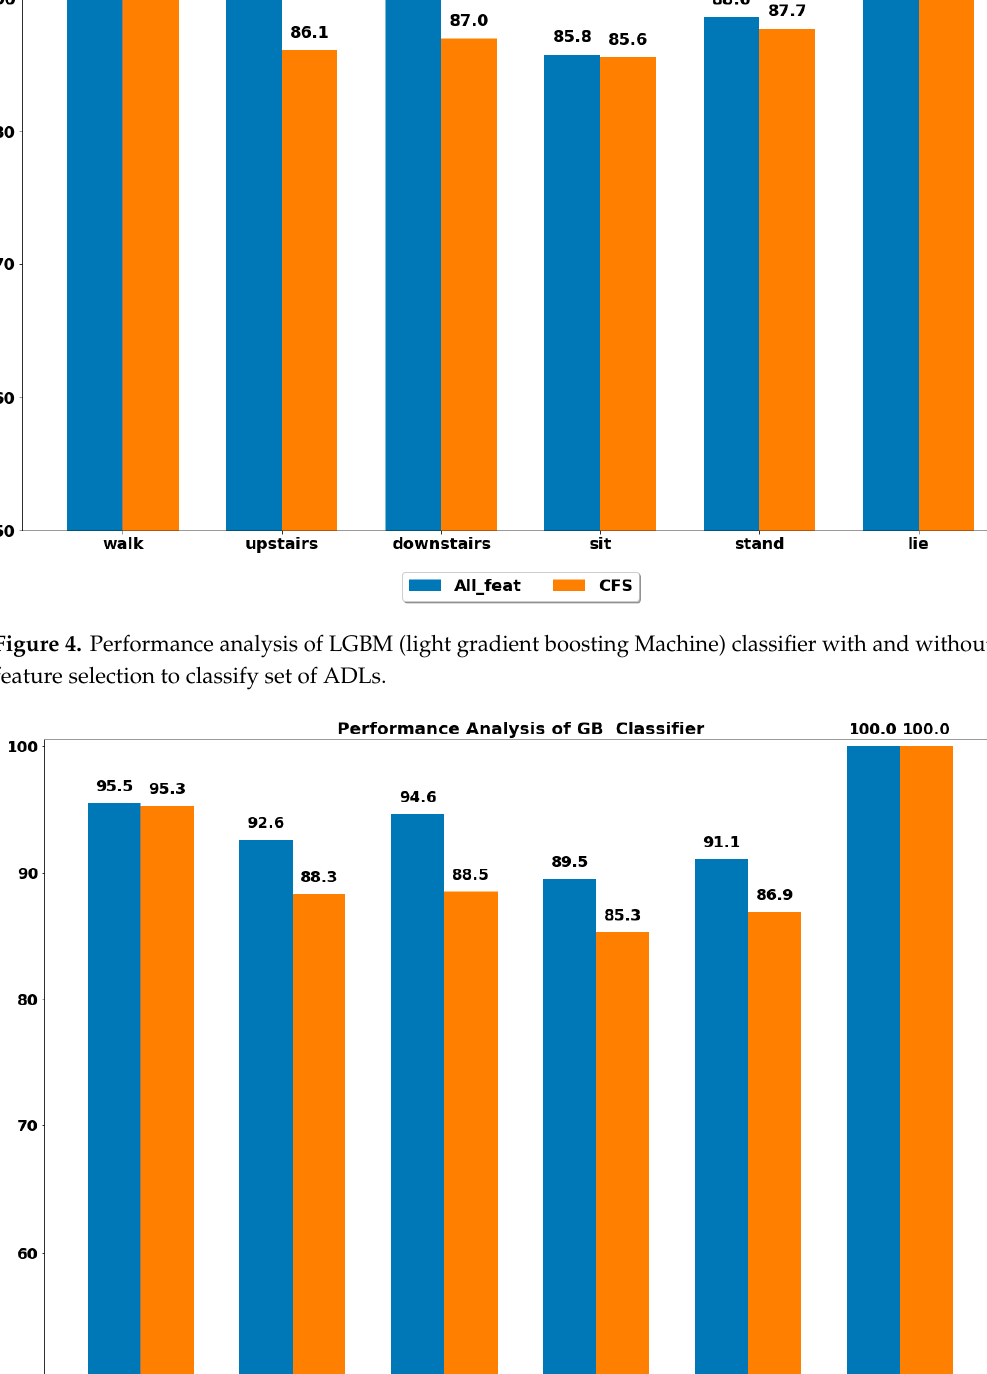
Figure 5. Performance analysis of GB (gradient boosting) classifier with and without feature selection to classify set of ADLs.